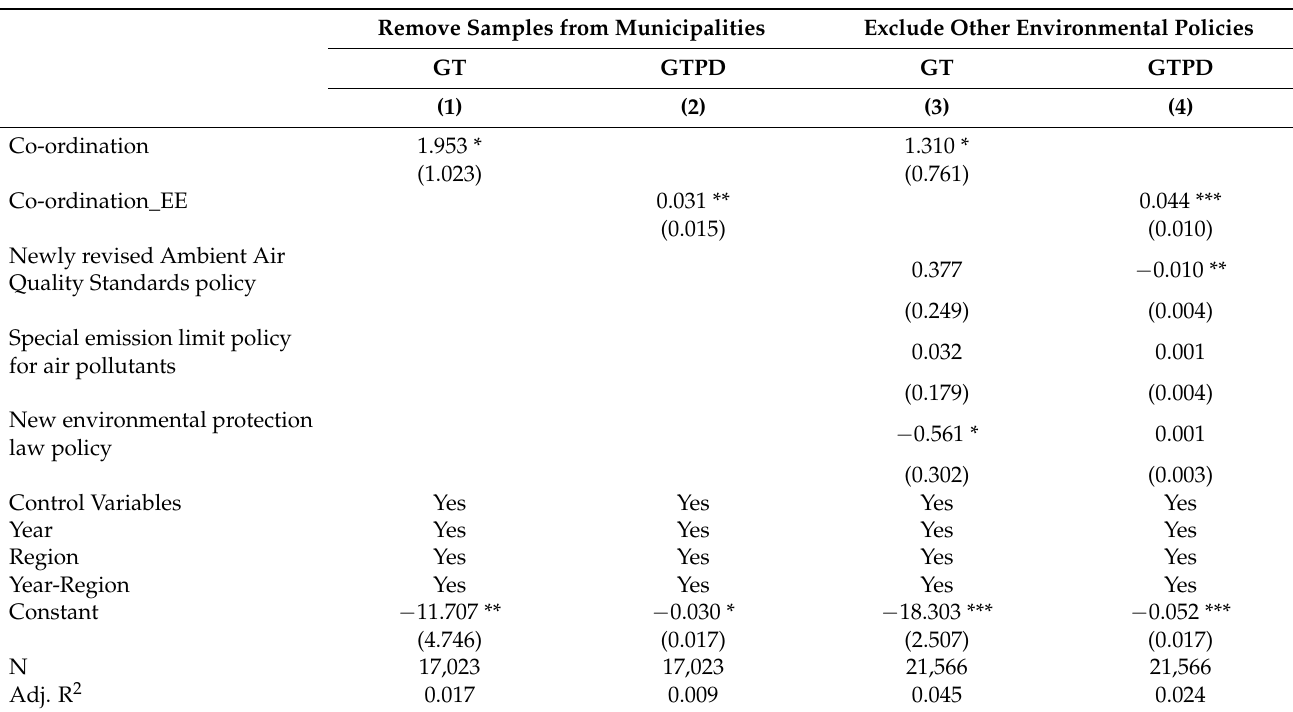
Table 7. Robustness test for excluding some samples and controlling for other